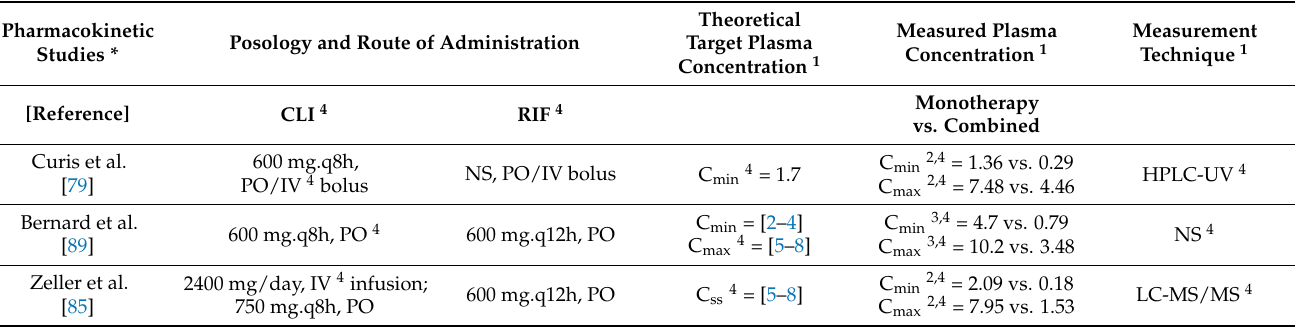
Table 6. Summary of relevant prospective pharmacokinetic studies for cotreatment of clindamycin and rifampicin in bone and joint